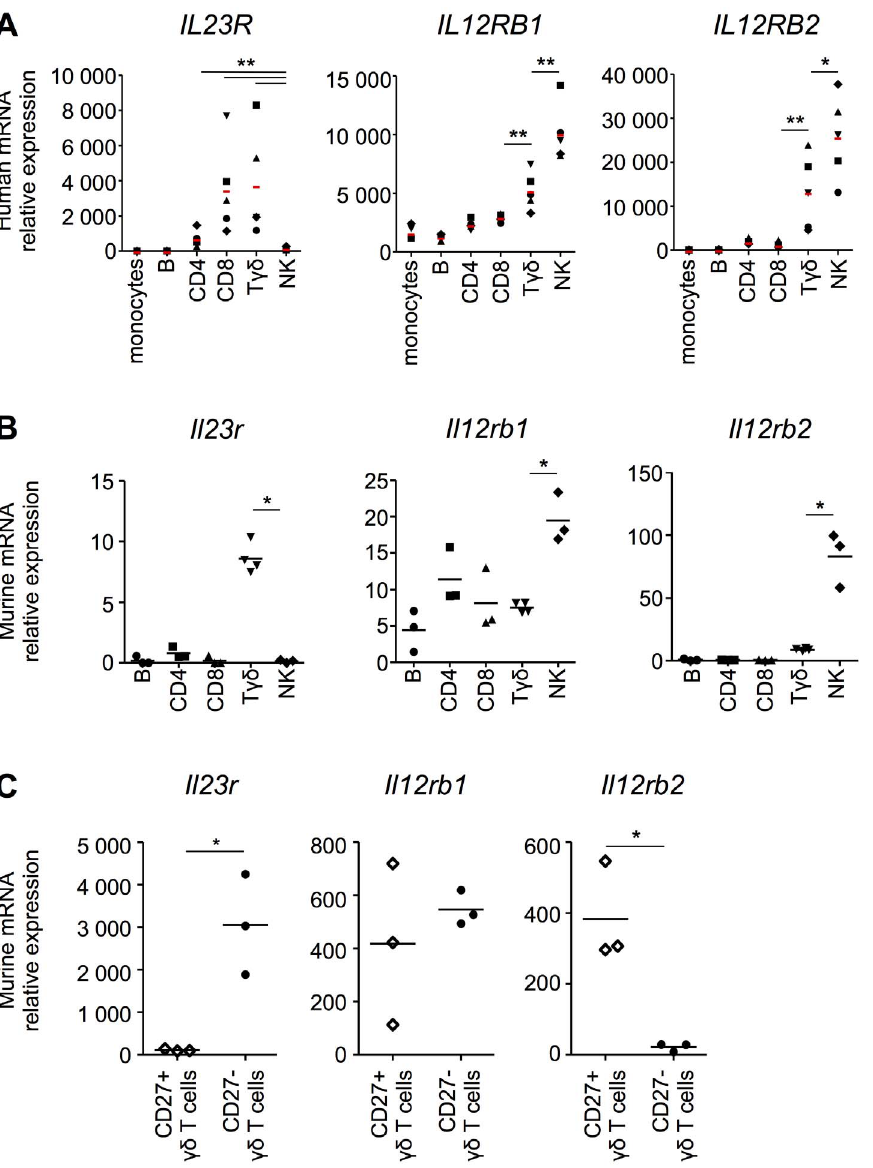
Figure 1. IL23R and IL12RB2 are not transcribed within the same lymphocyte populations. The relative mRNA transcription level of IL23R , IL12RB1 and IL12RB2 in (A) different sorted PBMC populations of healthy donors and in (B) murine sorted spleen cell populations is shown. (C) The relative mRNA transcription level of Il23r , Il12rb1 and Il12rb2 in sorted CD27 + / 2 cd T cell populations from mouse spleens is shown. For all panels, the horizontal bar represents the mean of each group and each symbol represents one sample.*, p , 0.05, ** p , 0.01.